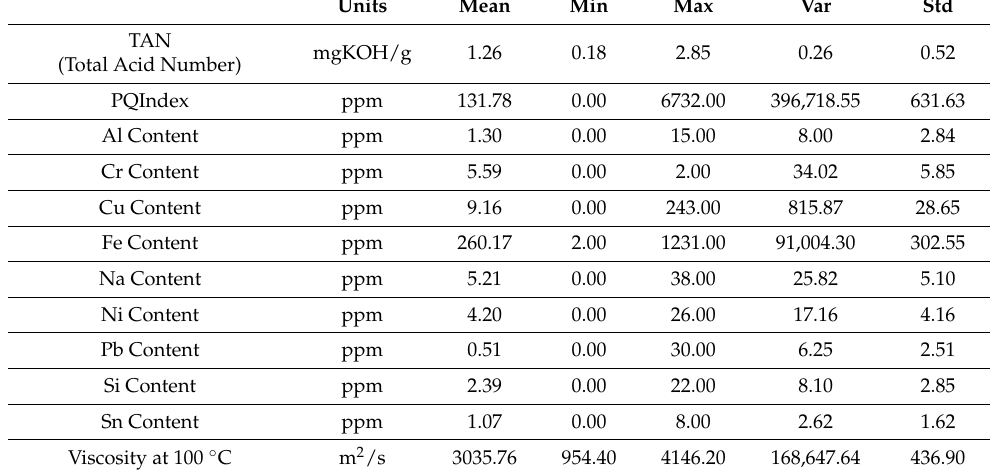
Table 1. Metrics of Oil Analysis.